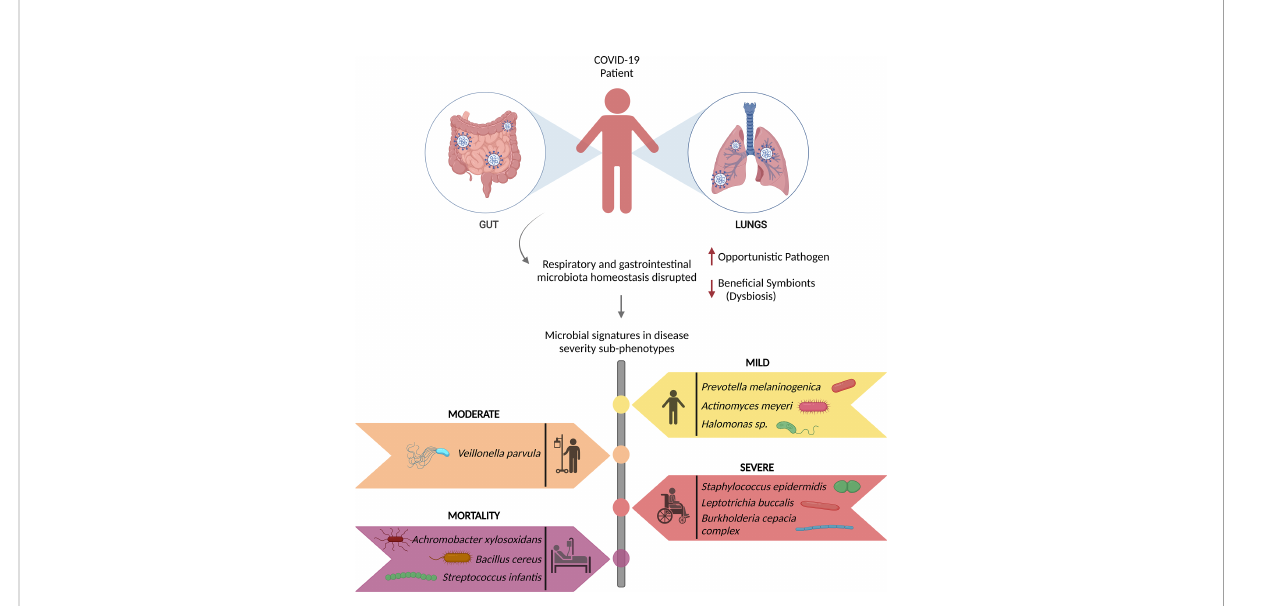
FIGURE 3 Microbial signatures associated with COVID-19 disease severity. SARS-CoV-2 infection causes gut and respiratory microbial dysbiosis, which results in several disease sub-phenotypes, mild, moderate, severe, and mortality, each with its own set of microbial signatures that can be identi fi ed as biomarkers for the speci fi c